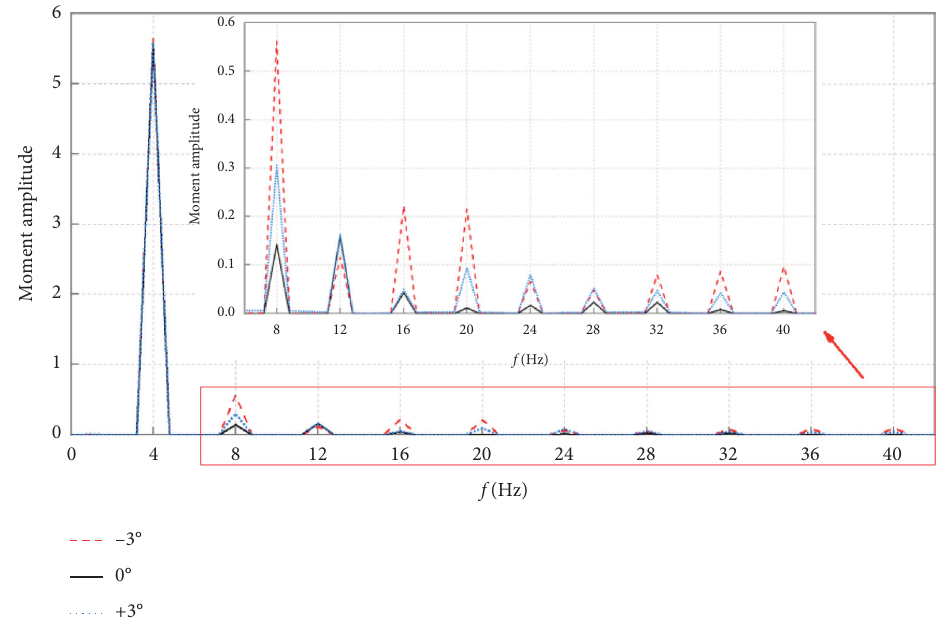
Figure 18: Aerodynamic moment spectrum under single frequency heaving motion of large amplitude.